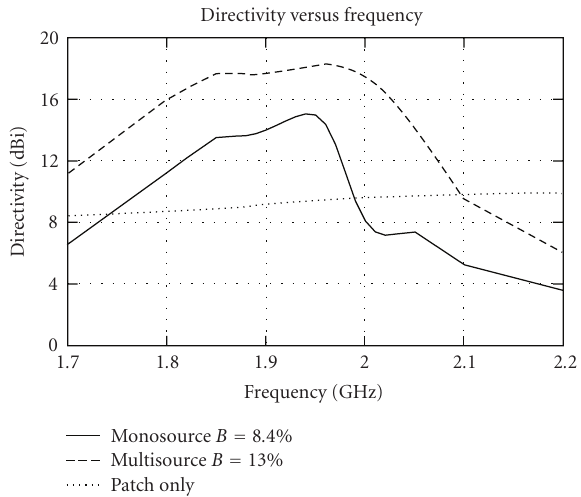
Figure 16: Front, top, and 3D views of the sectoral EBG antenna.